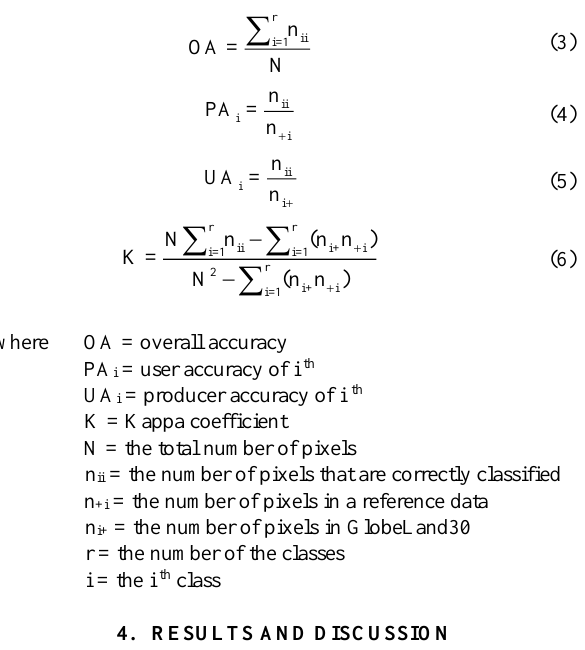
Figure 4 and 5 are the histogram of percentages of different land types. Table 2 and 3 are results obtained by area error